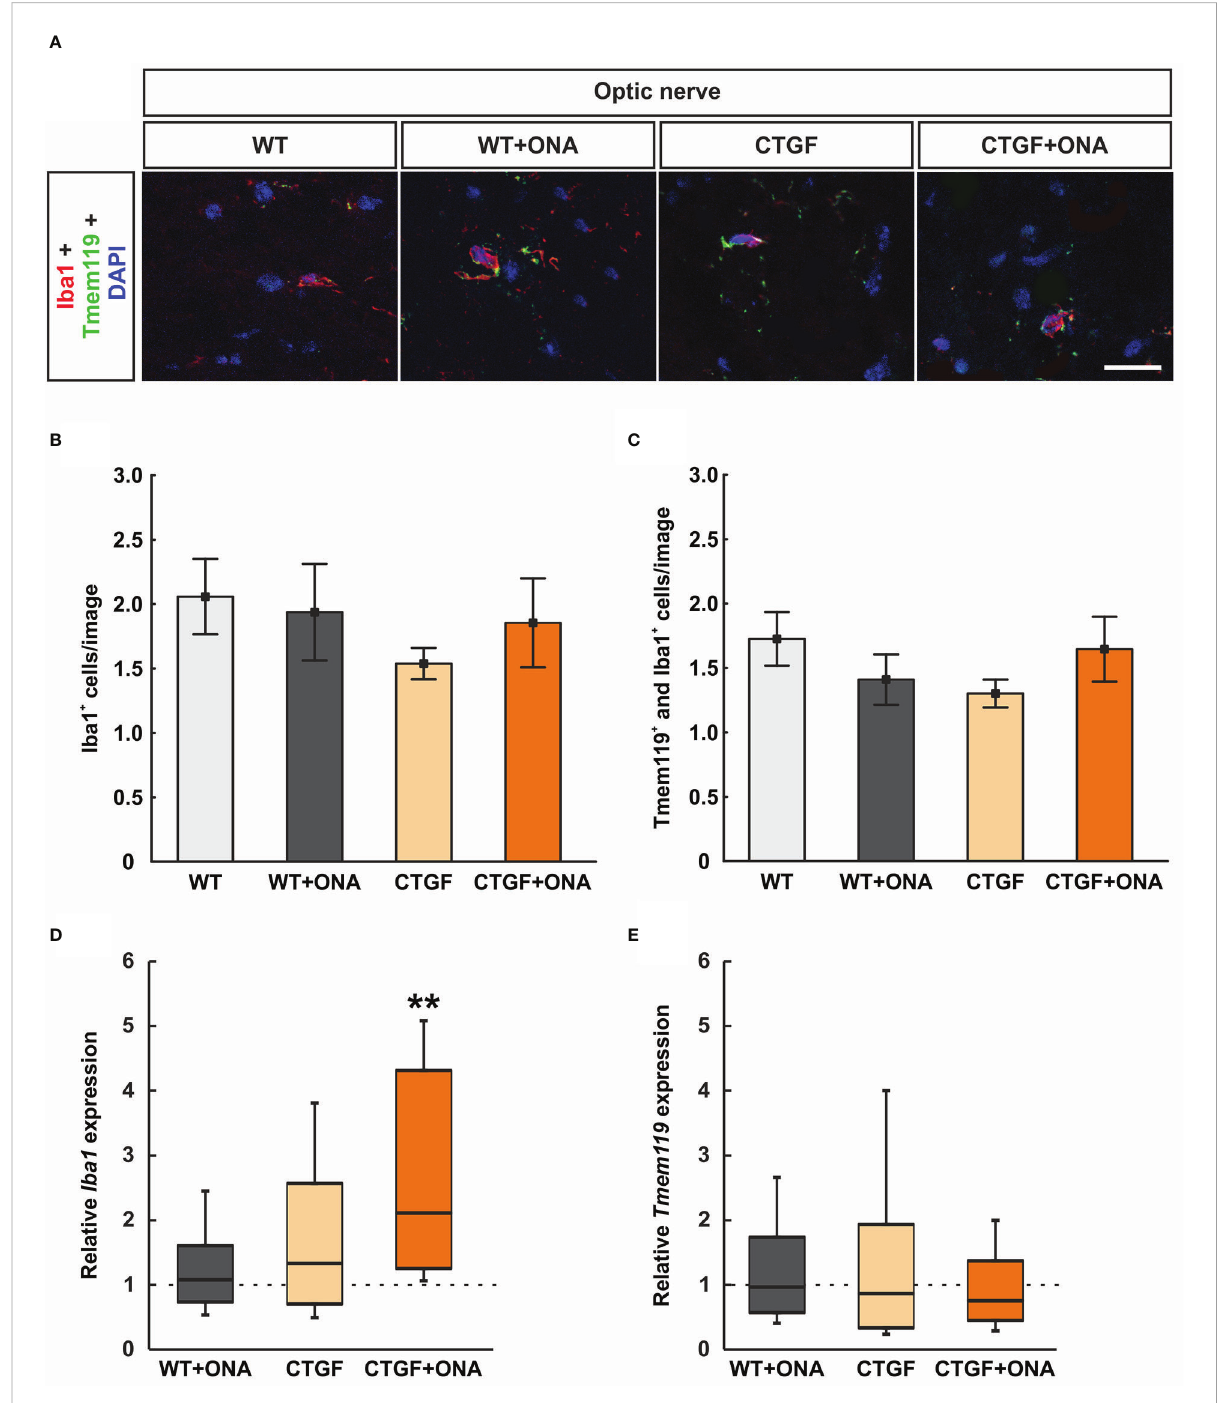
FIGURE 5 No microglia activation in CTGF+ONA optic nerves (A) Microglia/macrophages were labelled with anti-Iba1 (red) and microglia with double staining with anti-Tmem119 (green). DAPI counterstained cell nuclei (blue). (B) The number of Iba1 + cells was not different within all groups. (C) Also, no changes were observed in the number of Tmem119 + and Iba1 + double positive cells within all groups. (D) The mRNA expression levels of Iba1 were not altered in WT+ONA and CTGF optic nerves, while a signi fi cant upregulation was noted in the CTGF+ONA group. (E) Tmem119 mRNA expression levels were equivalent in all groups. Values are mean ± SEM for immunohistology and median ± quartile ± minimum/maximum for RT-qPCR. The dotted lines in (D, E) represent the relative expression of the WT group. **p<0.001 vs . WT. Scale bars: 20